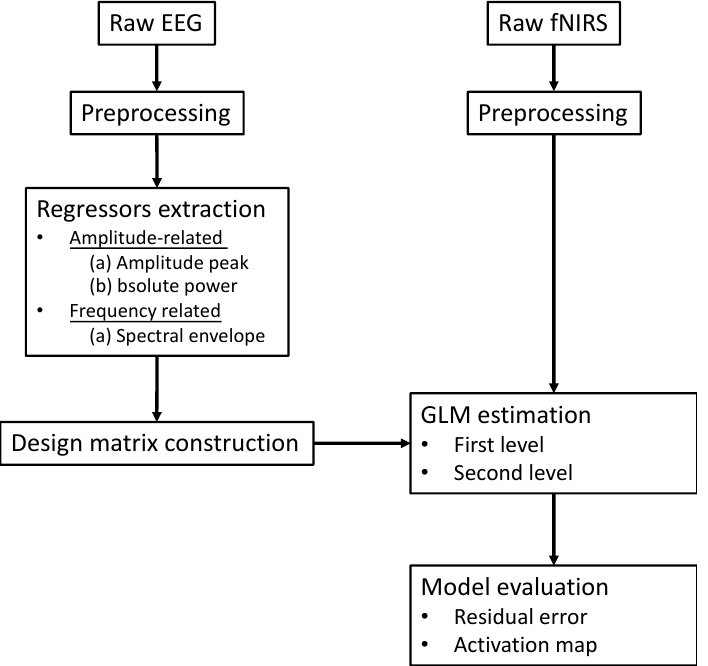
Figure 7. The conventional schematic of EEG-informed fNIRS GLM analysis framework.